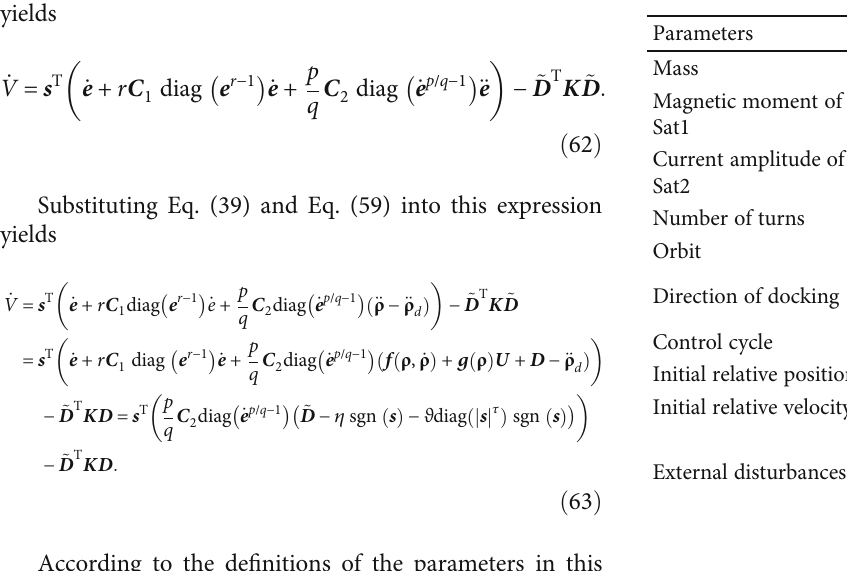
Table 1: Simulation